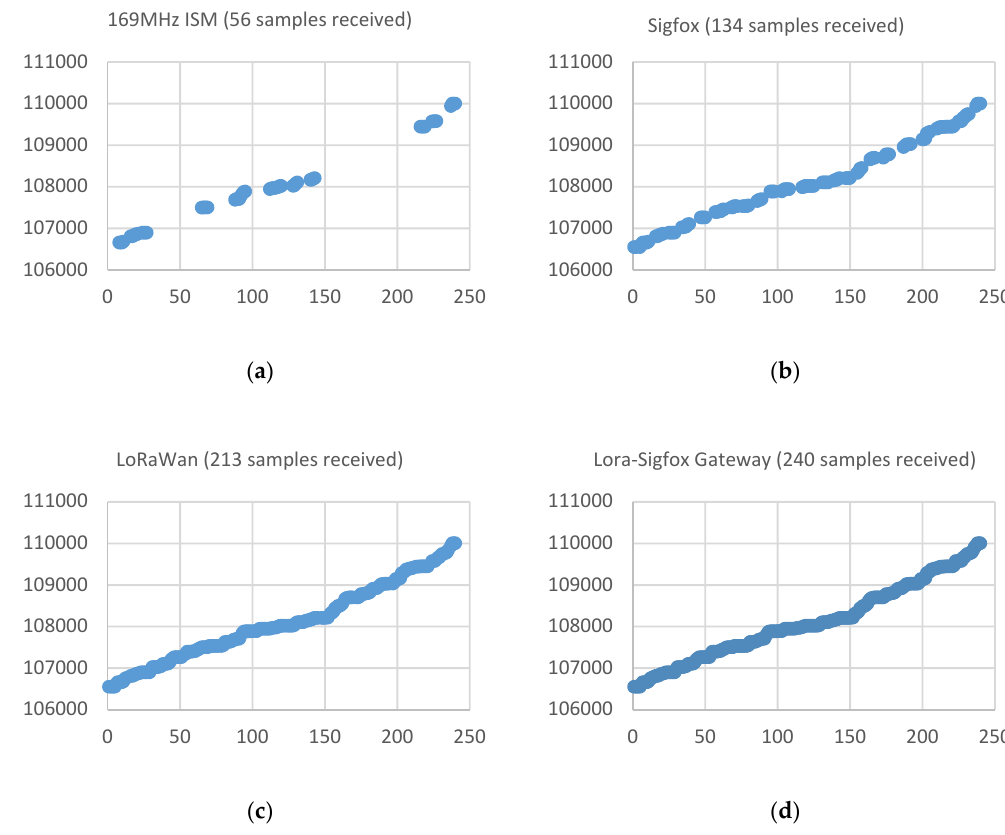
Figure 22. Number of samples received in the case of a building in which the reception rate is below the Q1 quartile (25%). ( a ) In the 169 MHz ISM band, 56 samples were received (23.3%). ( b ) Reception rate with the Sigfox prototype of 55.8% ( c ) Reception rate with the LoRaWan device of 88.8% ( d ) Reception rate with the LoRa-Sigfox Gateway device of 100%.